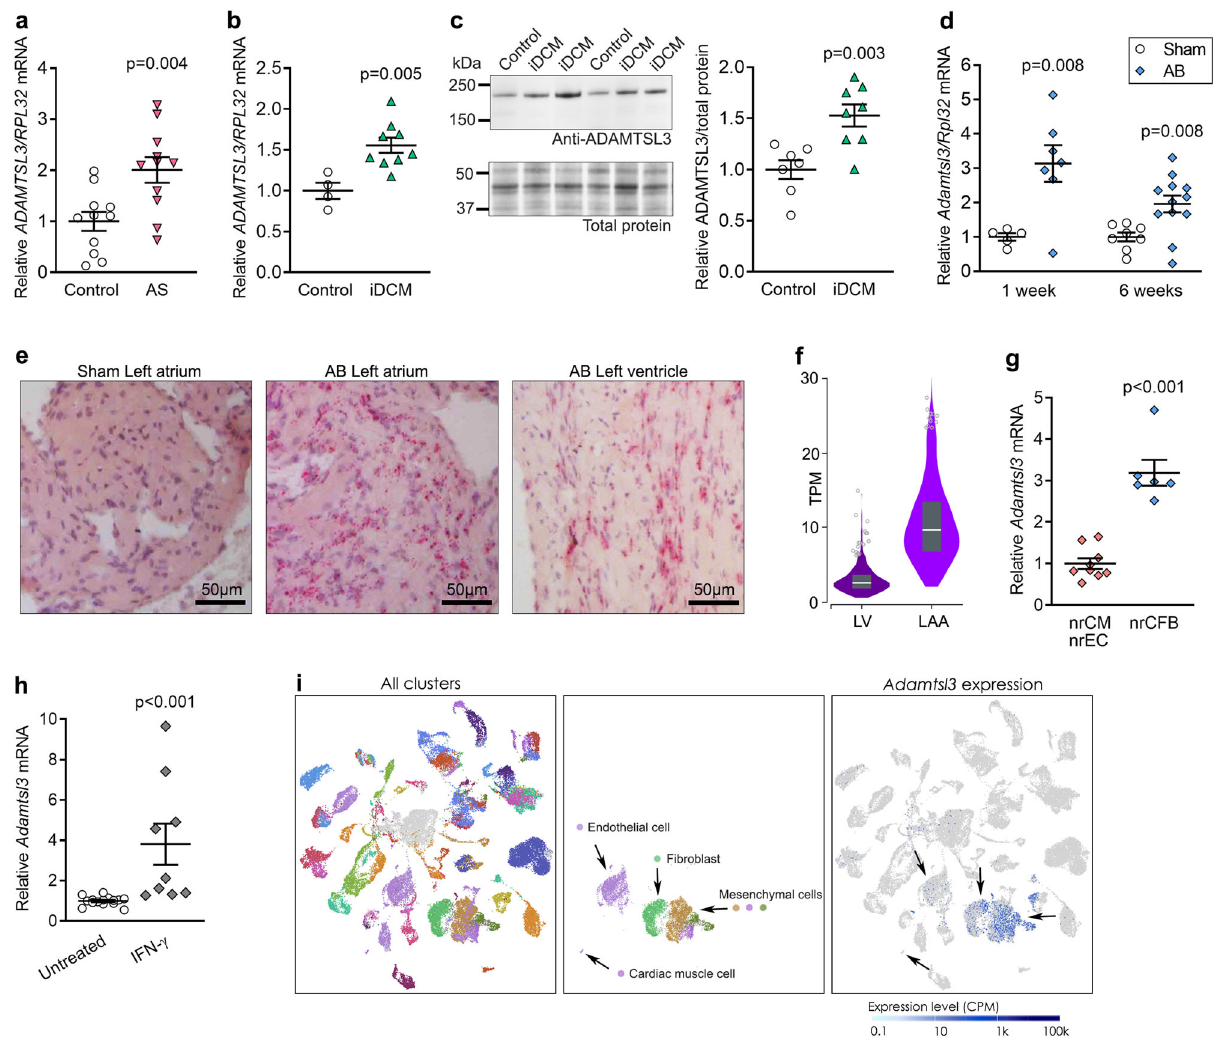
Fig. 1 ADAMTSL3 is upregulated in patients with heart failure and in wild-type mice with left ventricular pressure overload, and is produced by cardiac fi broblasts. a-b ADAMTSL3/RPL32 mRNA levels in left ventricular (LV) biopsies from patients with a aortic stenosis (AS, n = 11) and b ischemic dilated cardiomyopathy (iDCM, n = 9) vs. respective controls. c Western blot and quanti fi cation of ADAMTSL3 protein/total protein levels in LVs of patients with iDCM ( n = 8) vs. controls ( n = 7). d Adamtsl3/Rpl32 mRNA levels in LVs of wild-type (WT) mice 1 and 6 weeks after aortic banding (AB) or sham surgery ( n = 5 sham and n = 7 AB at 1 week, n = 8 sham and n = 12 AB at 6 weeks). e In situ hybridization of Adamtsl3 mRNA (red staining) in the left atrium of AB and sham-operated mice, and in the LV wall of AB mice, 4 weeks post-AB, with hematoxylin nuclear counterstain (purple). f RNA sequencing data from the Genotype-Tissue Expression (GTEx) project portal. In GTEx, a total of 17382 samples across 54 non-diseased tissues, from 948 deceased human organ donors, represents a control population. Donors are 20-70 years old, 33% female, 85% White and 13% African-American. ADAMTSL3 expression is shown as transcripts per kilobase million (TPM), in LV ( n = 432, median TPM = 2.54) and left atrial appendage (LAA, n = 429, median TPM = 9.66). g mRNA levels of Adamtsl3 in neonatal rat cardiac fi broblasts (nrCFB) and cardiomyocytes (nrCM), with presence of endothelial cells (nrEC), isolated from 1-3 day old rat hearts ( n = 3 isolations of n = 60 hearts, with n = 3 culture replicates per isolation). h mRNA levels of Adamtsl3 in untreated primary nrCFBs, and nrCFBs stimulated with 5 ng IFN- γ . Data are scatterplots ( a – d , g – h ) or violin plot f with mean ± SEM. Statistical analyses was performed using the Student ’ s t -test vs. respective controls ( a – d , g – h ). i Data from the EMBL-EBI Single Cell Expression Atlas. All clusters with 82 cell types from 20 mouse tissues ( n = 3 female and n = 4 male 10-15 week old mice) 22 , and extraction of endothelial cells, cardiac muscle cells, fi broblasts and mesenchymal cells ( fi broblast progenitors) are shown, and the clustering of Adamtsl3 expression (blue dots). Scale bar is counts per million (CPM) reads